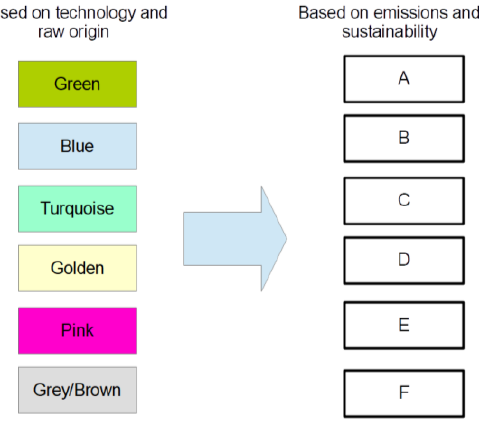
Figure 1. Hydrogen classification based on impacts instead of technologies.